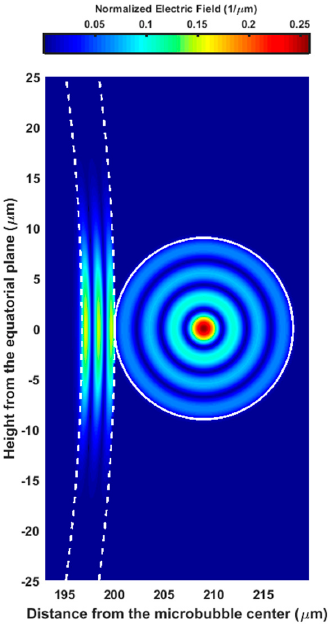
Figure 7. Distribution of the normalized electric fields confined in the microbubble glass layer (on the left) and in the fiber taper (on the right) for the WGM 998,998,3 coupled with the LP 0,4 , gap g = 0 nm.